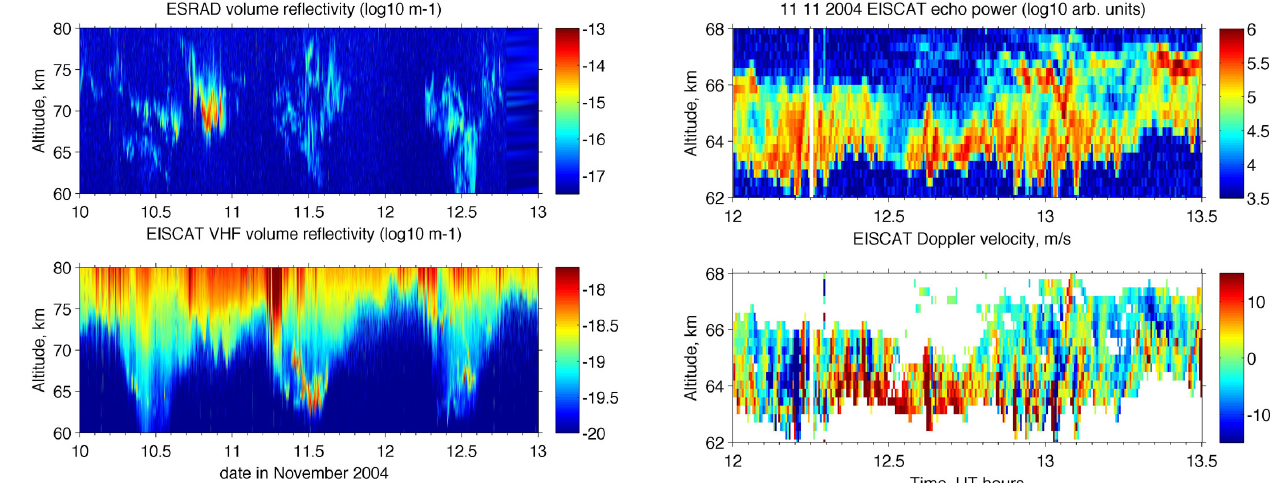
Fig. 2. EISCAT radar echo power (upper panel) and Doppler veloc- ity (lower panel) on 11 November